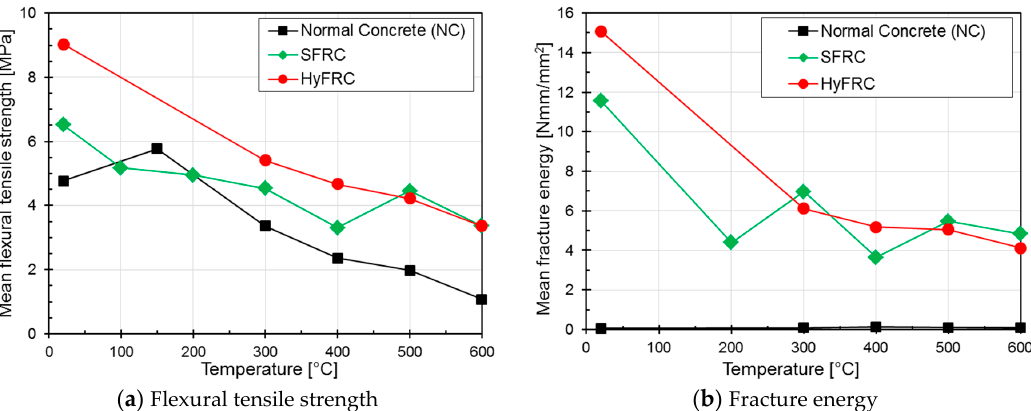
Figure 10. Variation of flexural tensile strength and fracture energy as a function of exposure